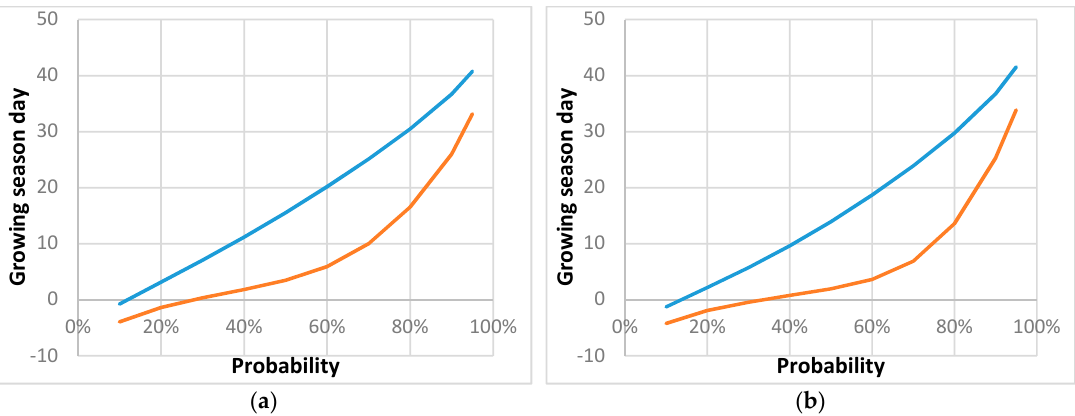
Figure 11. The probability curves of the last spring frost event described by a day number in the growing season (Tmin < − 4 °C) in the period of 1961–1990 (blue line) and 1991–2020 (orange line). ( a ) Wielichowo, ( b ) Sandomierz.